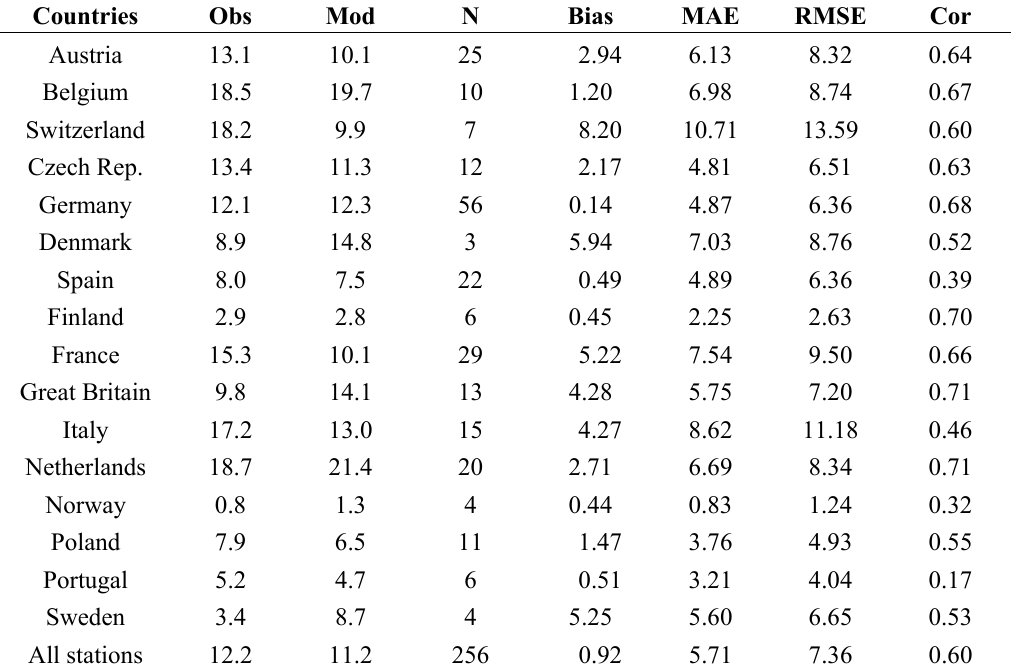
in comparison to AirBase stations data Table 2. Overview of model performance for NO 2 in European countries. Parameters presented include the mean observed (Obs) and modeled (Mod) concentrations (µg/m 3 ) across N stations. Additional parameters are the mean absolute error (MAE), the root mean square error (RMSE) and the temporal correlation coefficient